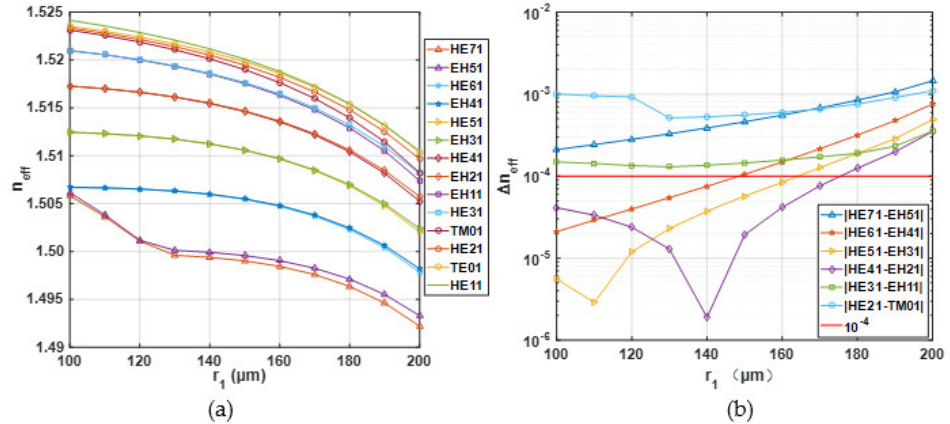
Figure 3. ( a ) The effective refractive index as a function of the radius r 1 for different vector modes. ( b ) The effective refractive index difference as a function of the radius r 1 for EH and HE modes. Table 1. Main parameters in the simulation.